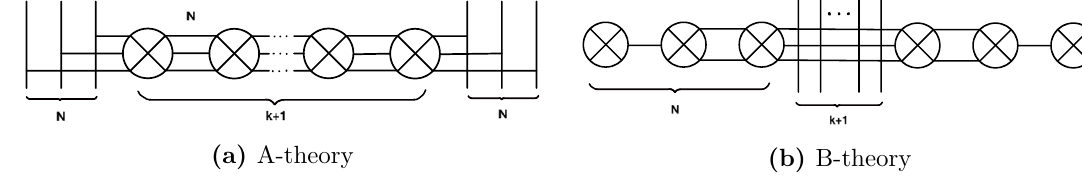
Figure 8. HW setups of the homogeneous quiver (a) and its mirror (b) .